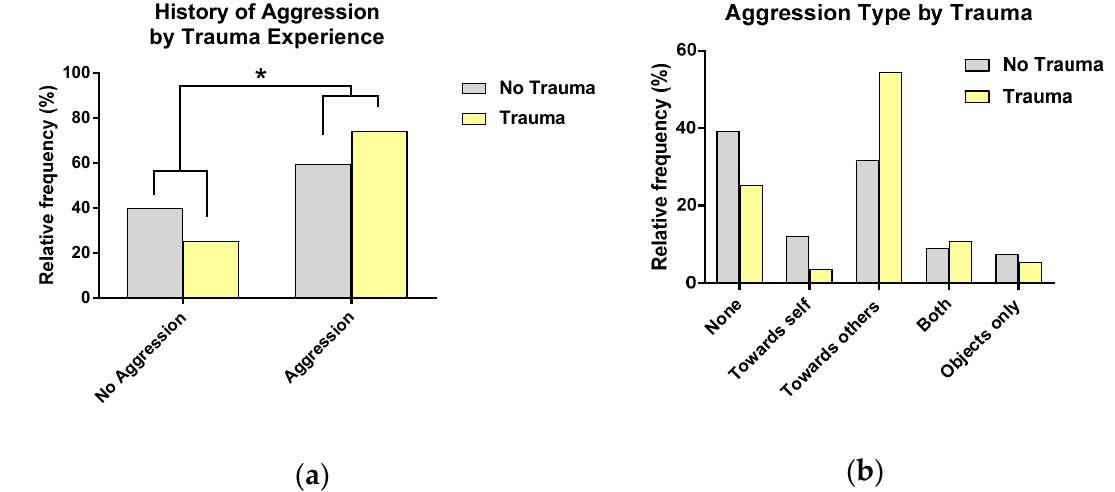
Figure 2. Relationships between trauma history and aggression: ( a ) A higher proportion of those with a history of aggression report having a history of trauma and ( b ) proportions of reported aggression types are similar across trauma no trauma groups, except for aggression towards others where a higher proportion of those reporting aggression towards others reported a history of trauma. * p < 0.05